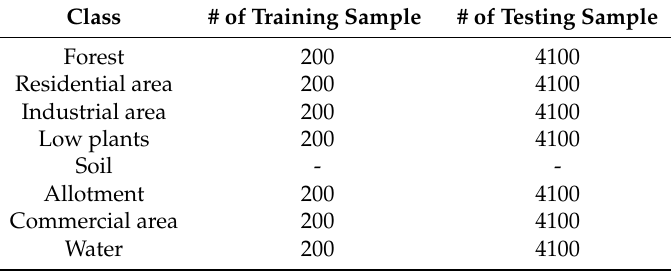
Table 3. Summary of the training data and the testing data for the scene of city